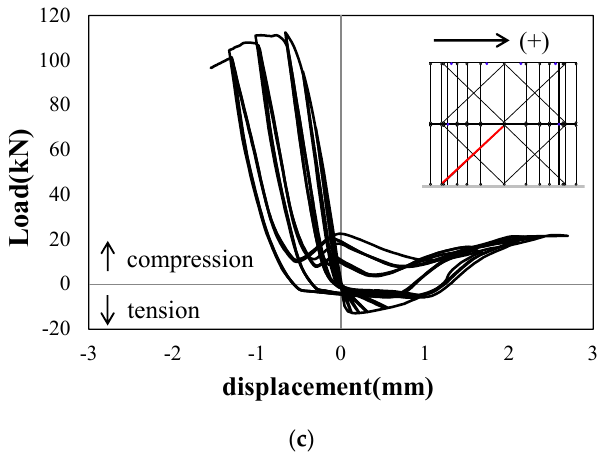
Figure 20. Estimated load–displacement responses of elements in Specimen FBC: ( a ) column; ( b ) longitudinal element; ( c ) diagonal element.